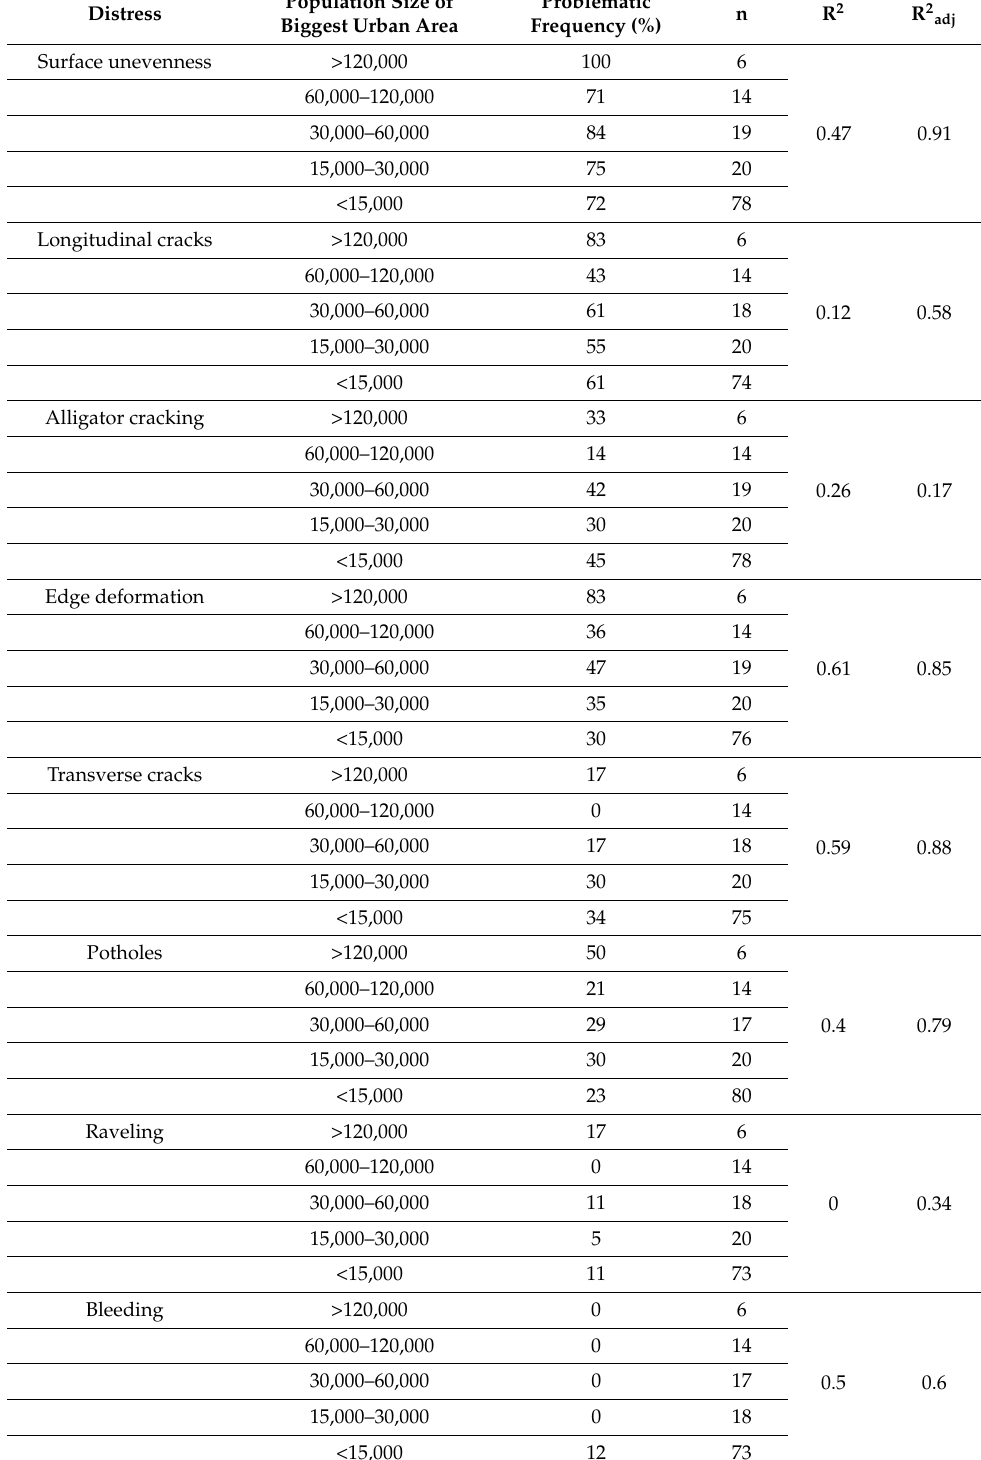
Table A3. The table shows the correlation between the stated distress modes and the problematic frequency with respect to population size of the biggest urban area of each municipality. Bold R 2 values represent a strong correlation, as shown in Figure